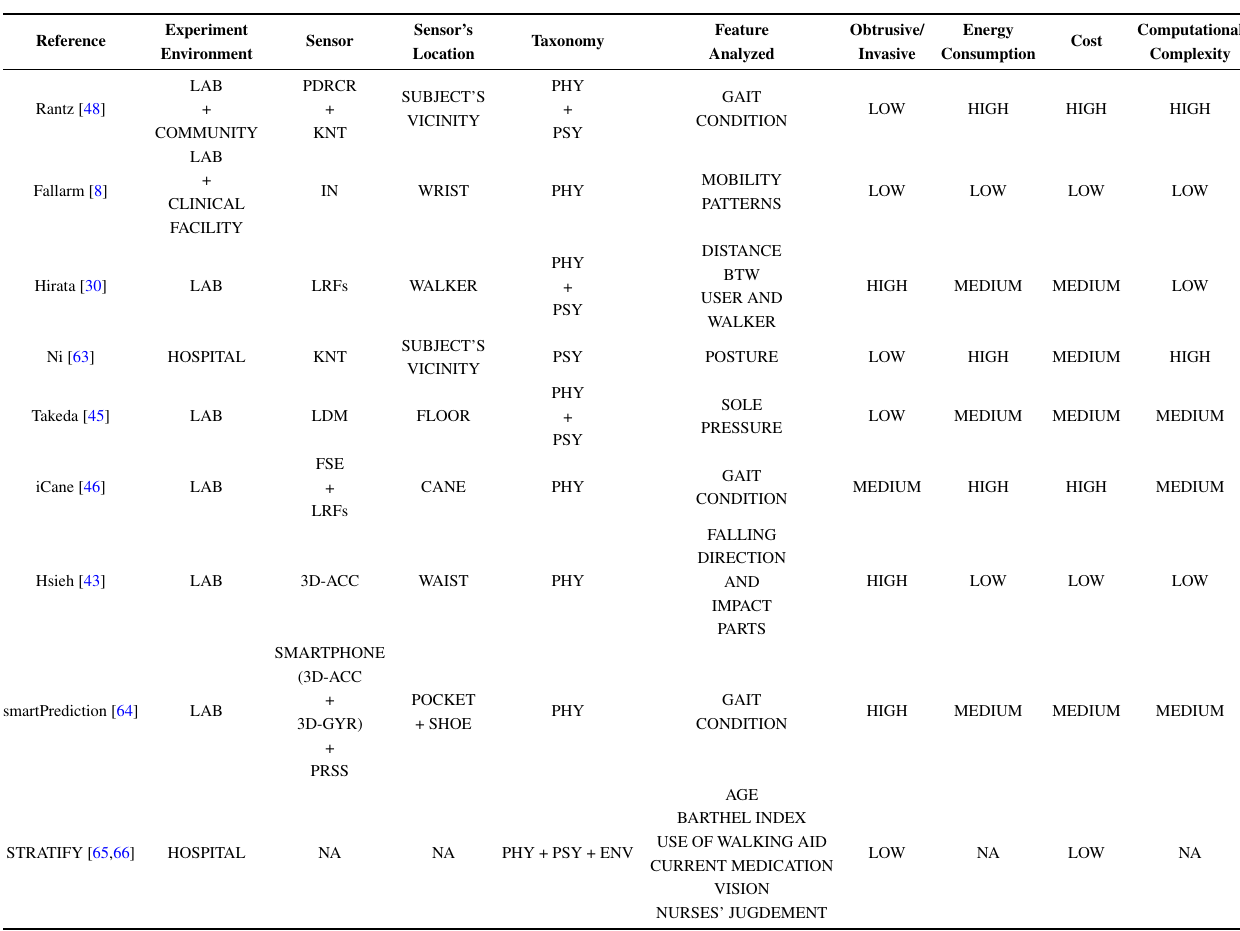
Table 5. Summary of state-of-the-art fall prevention